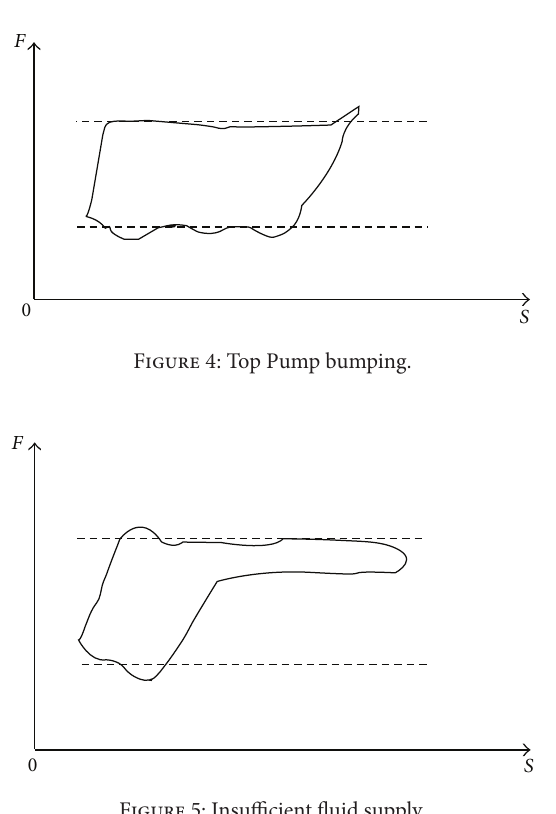
Figure 5: Insufficient fluid supply.